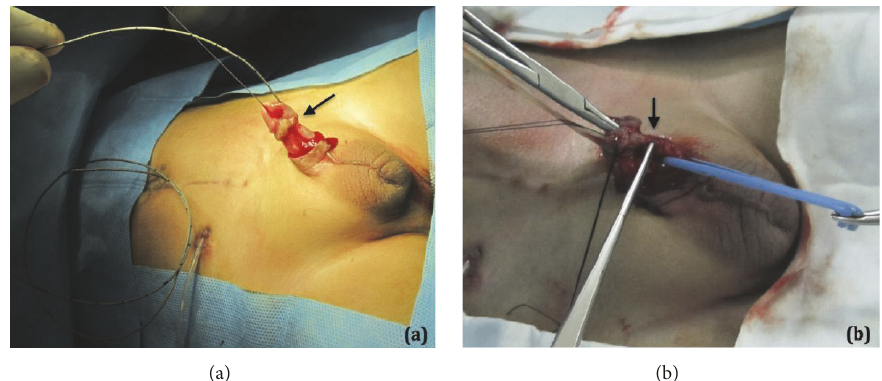
Figure 2: (a) A 3-Fr ureteric catheter is blocked at the obstruction point at 1 cm from urethral meatus (arrow); also note the midline scar of previous surgery and suprapubic catheter; (b) the black arrow point to the fibrotic site obstructing the urethra.